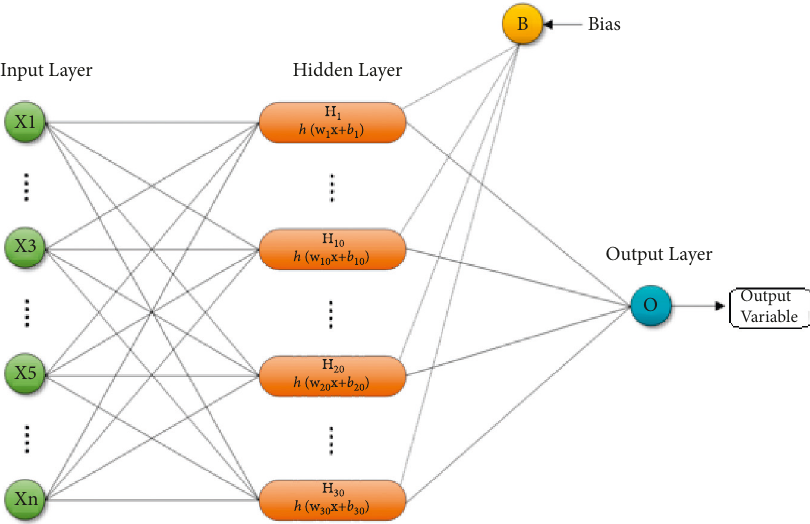
Figure 2: Architecture of ELM model.